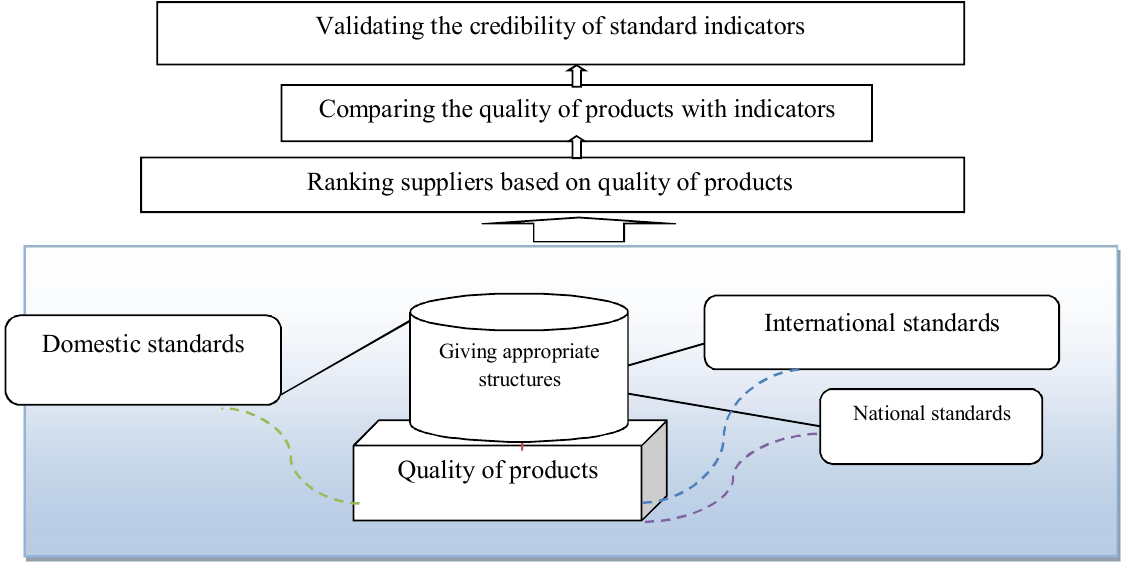
Fig. 1. The proposed model